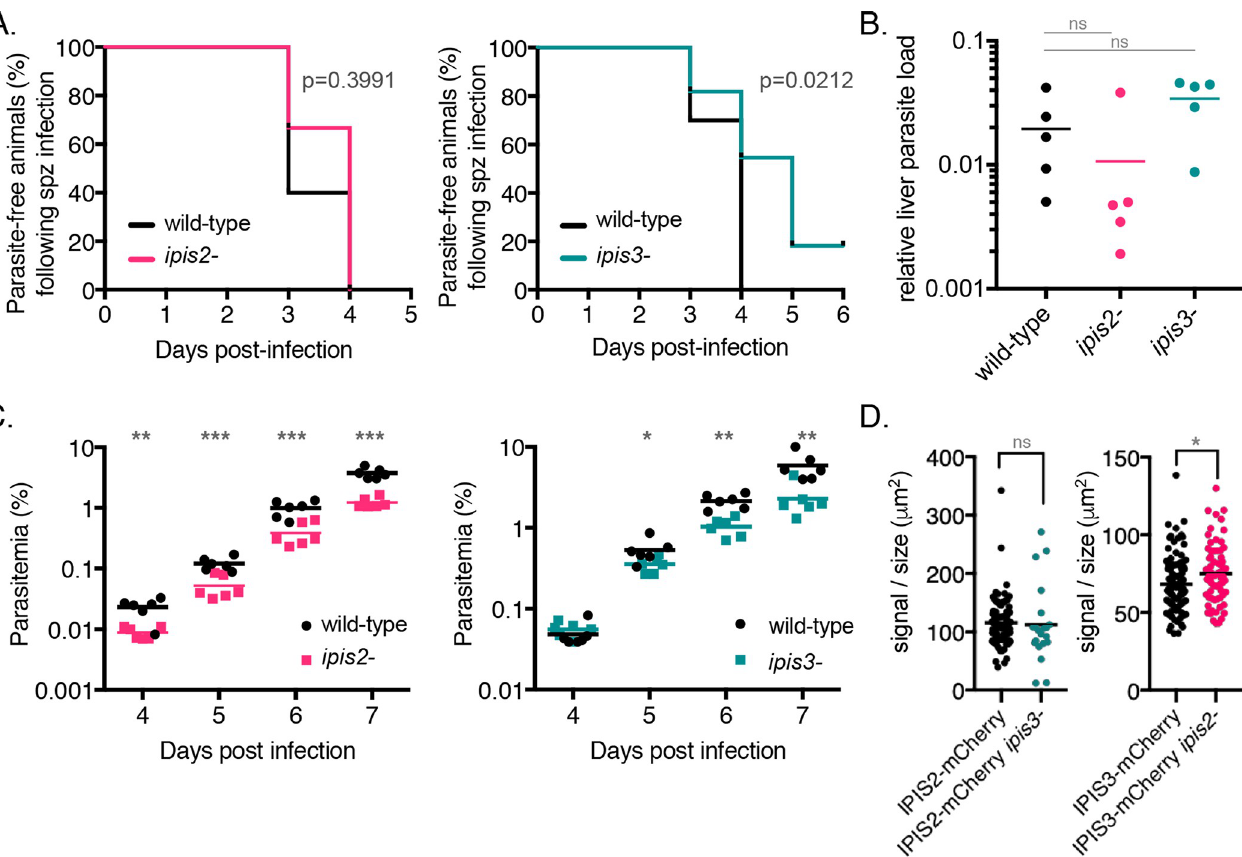
Fig 4. ipis2- and ipis3- contribute to blood-stage growth efficiency during P . berghei infection. A) The appearance of ipis3- parasites in the blood following sporozoite injection is delayed in comparison to wild-type. C57BL/6 mice were infected with 1,000 sporozoites of either ipis2- , ipis3- or wild-type parasites, and blood-stage infections were monitored starting from day 3 post-infection with Giemsa-stained blood smears. Statistics: Log-rank (Mantel-cox) test; n = 5 ( ipis2- ), n = 10 ( ipis3- ). B) The growth of ipis2- and ipis3- parasites in the liver does not differ significantly from wild-type P . berghei . The relative parasite burden in the liver was measured by qPCR of RNA extracted from livers forty-two hours after intravenous injection of either ipis2- , ipis3- , or wild-type sporozoites. Levels of Pb 18s rRNA were normalized to levels of mouse GAPDH RNA in each infected liver. Statistics: unpaired two-tailed t-test; n = 5; ns: not significant. C) The ipis2- and ipis3- lines do not grow as efficiently as wild type in the blood of co-infected animals. Mice were infected with equal amounts of wild-type P . berghei - infected erythrocytes and ipis2- [mCherry; PyrS] or ipis3- [mCherry; PyrS] infected erythrocytes. Parasitemia was measured by flow cytometry between days 4–7 after infection. � p < 0.05, �� p < 0.01, ��� p < 0.005 determined by unpaired two-tailed t-test; n = 5. D) The absence of one IPIS protein does not dramatically influence the expression level of the other. Erythrocyte-associated mCherry signal was quantified in fixed unstained infected cells. The mCherry signal intensity was plotted as a ratio to parasite size to account for differences in expression in different stages. In the ipis2 - line, a statistically significant increase in mCherry signal was detected; however the extent was negligible. � p < 0.05, unpaired two-tailed t-test.